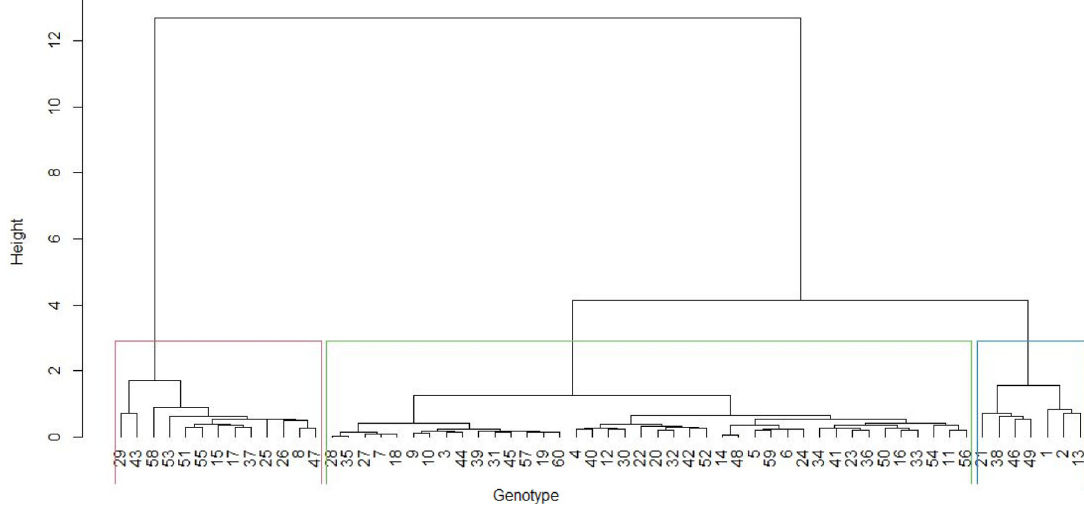
Fig 6. Dendrogram showing genetic relatedness among the 60 common bean genotypes based on the genotypic matrix.